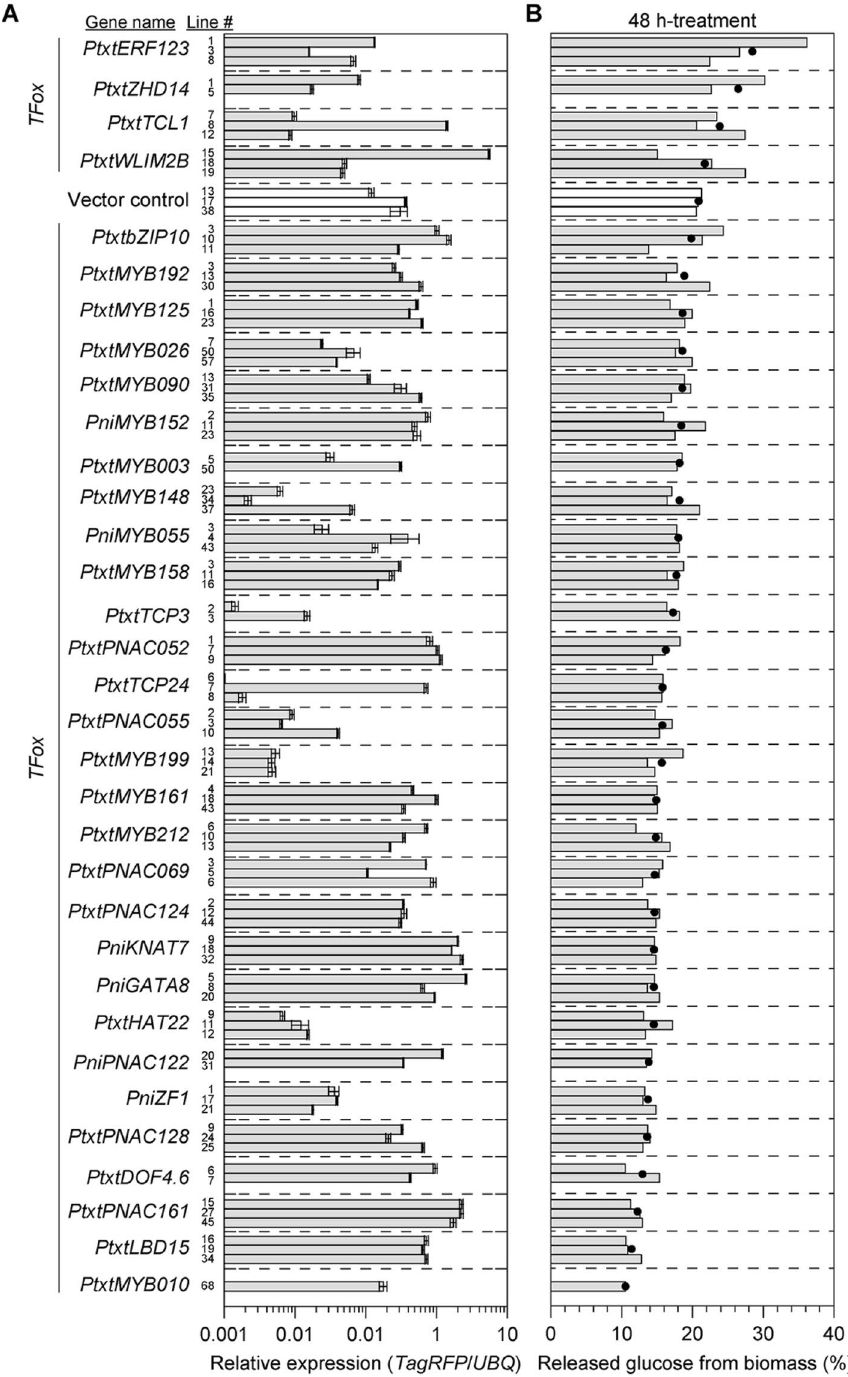
Figure 1. Relative expression level of the transgene (TF-TagRFP) in transgenic hybrid aspens measured by real-time PCR using primer pairs specific to the RFP ( A ). pGWB560 harboring the NLS-TagRFP was used as a vector control. TagRFP regions fused with each introduced gene as well as vector control were amplified. No amplicon was detected in wild type of T89 plants. Released glucose amounts from biomass (wt/wt %) of seedling stems of the transgenic hybrid aspens grown in MS culture under aseptic condition after 48 h-treatment with enzyme cocktail ( B ). A series of TFs were sorted by average of released glucose (%) from different lines generated from the same genotype (filled